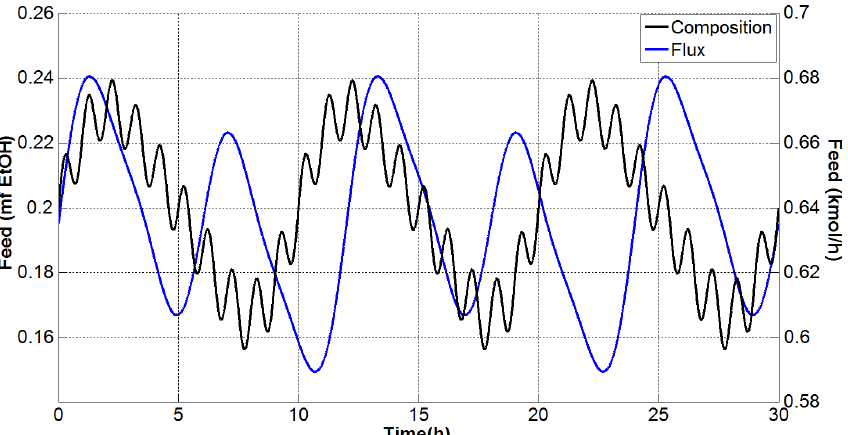
Figure 10. Perturbations of the sum of three sinusoidal functions in the feed flow and three sinusoidal functions in the feed